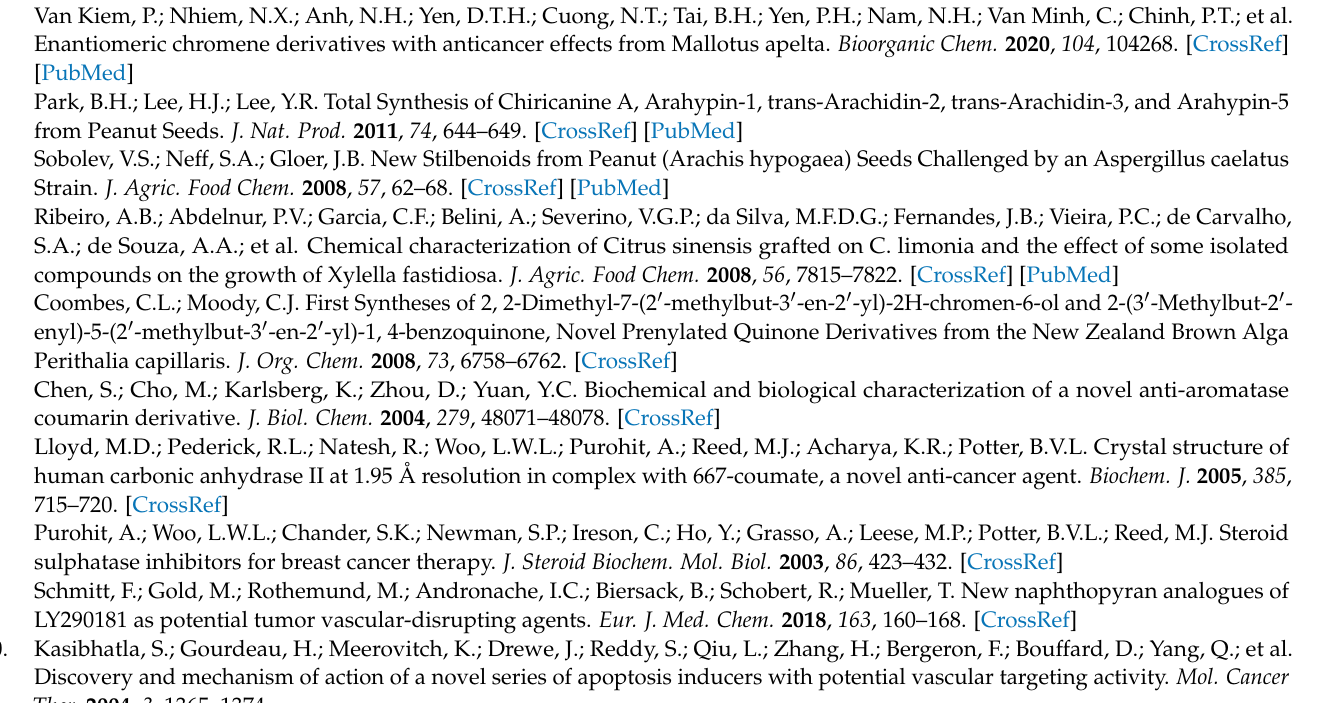
10.3390/cryst12050737/s1, Figure S1: 1H NMR of compound 4 , Figure S2: 1H NMR 8-6 ppm of compound 4 , Figure S3: 13 C NMR of compound 4 , Figure S4: 13 CNMR-DPT 45 of compound 4 , Figure S5: 13 CNMR-DPT 90 of compound 4 , Figure S6: 13 CNMR-DPT 135 of compound 4 , Figure S7: 13 CNMR-APT of compound 4 , Figure S8: The number of atoms for compound 4 viewed along the a-axis direction, Figure S9: Packing viewed along the b-axis direction with C-H ••• N hydrogen bonds shown as light purple dashed lines, Figure S10: Detail of the intermolecular interactions forming one chain viewed along the b-axis direction. N-H ••• N and Cl ••• H-O hydrogen bonds are shown as blue dashed lines, Table S1: Selected experimental and theoretical geometrical parameters for compound 4 , Table S2: Topological parameters at BCP of compound 4 (electron density( ρ (r)), Laplacian of electron density ( ∇ 2 ρ (r)), ellipticity ( ε ), Hamiltonian form of kinetic energy density (K(r)) and distance (D, in A0) of bond path length (BPL) from the nuclear attractors), and compound 4 check CIF file, Table S3: Crystal data and structure refinement parameters for compound 4